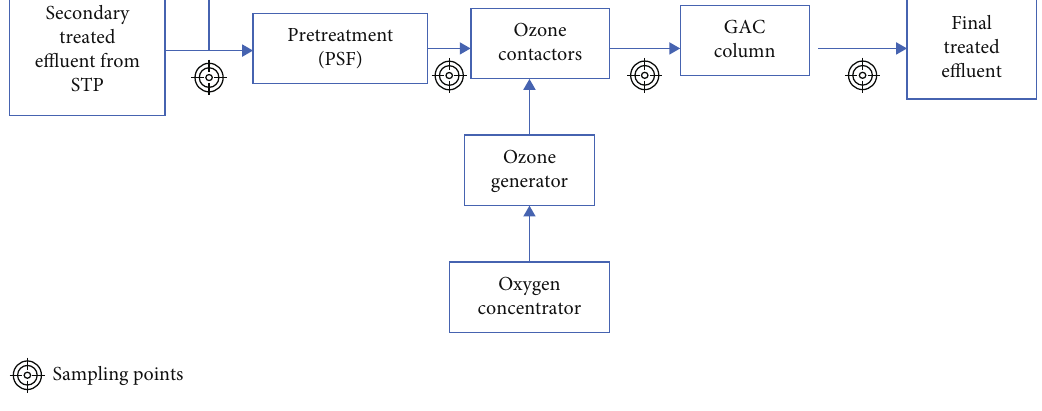
Figure 2: Treatment con fi guration 2.